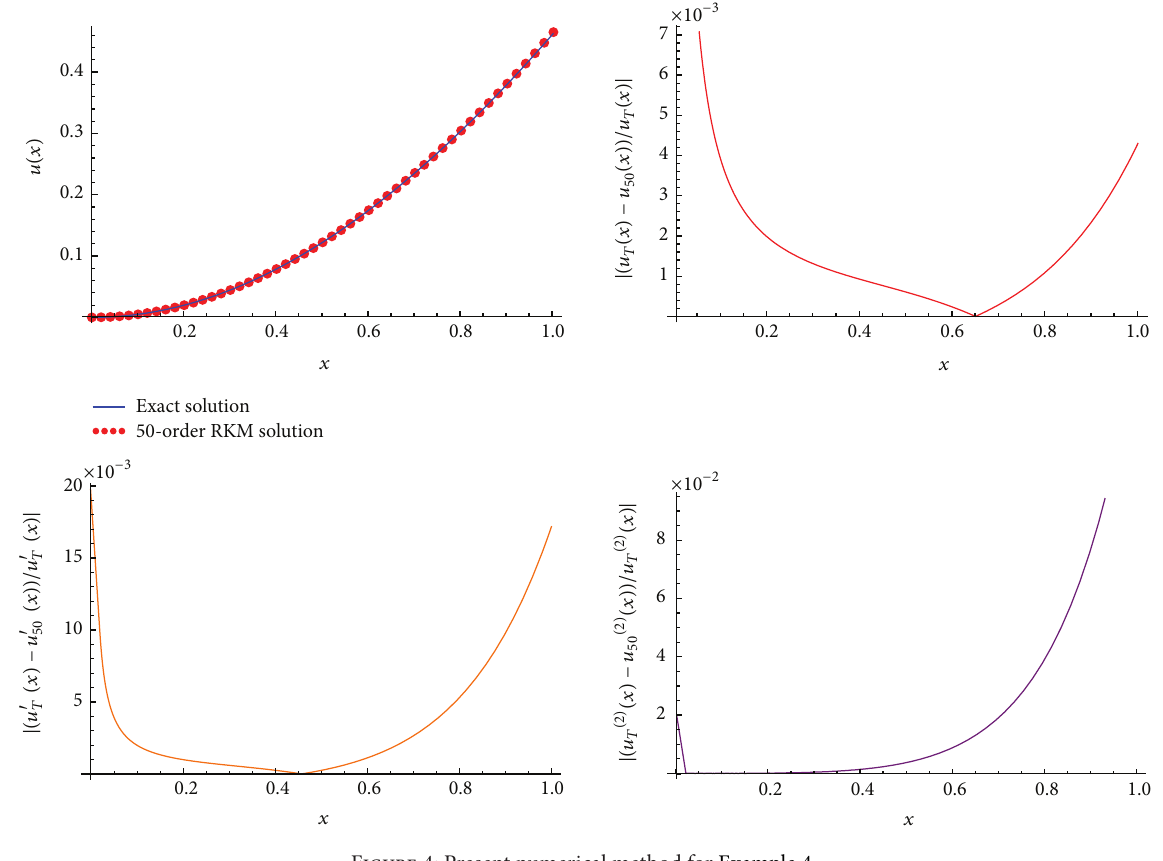
Figure 4: Present numerical method for Example 4. Table 3: Numerical solutions for Example